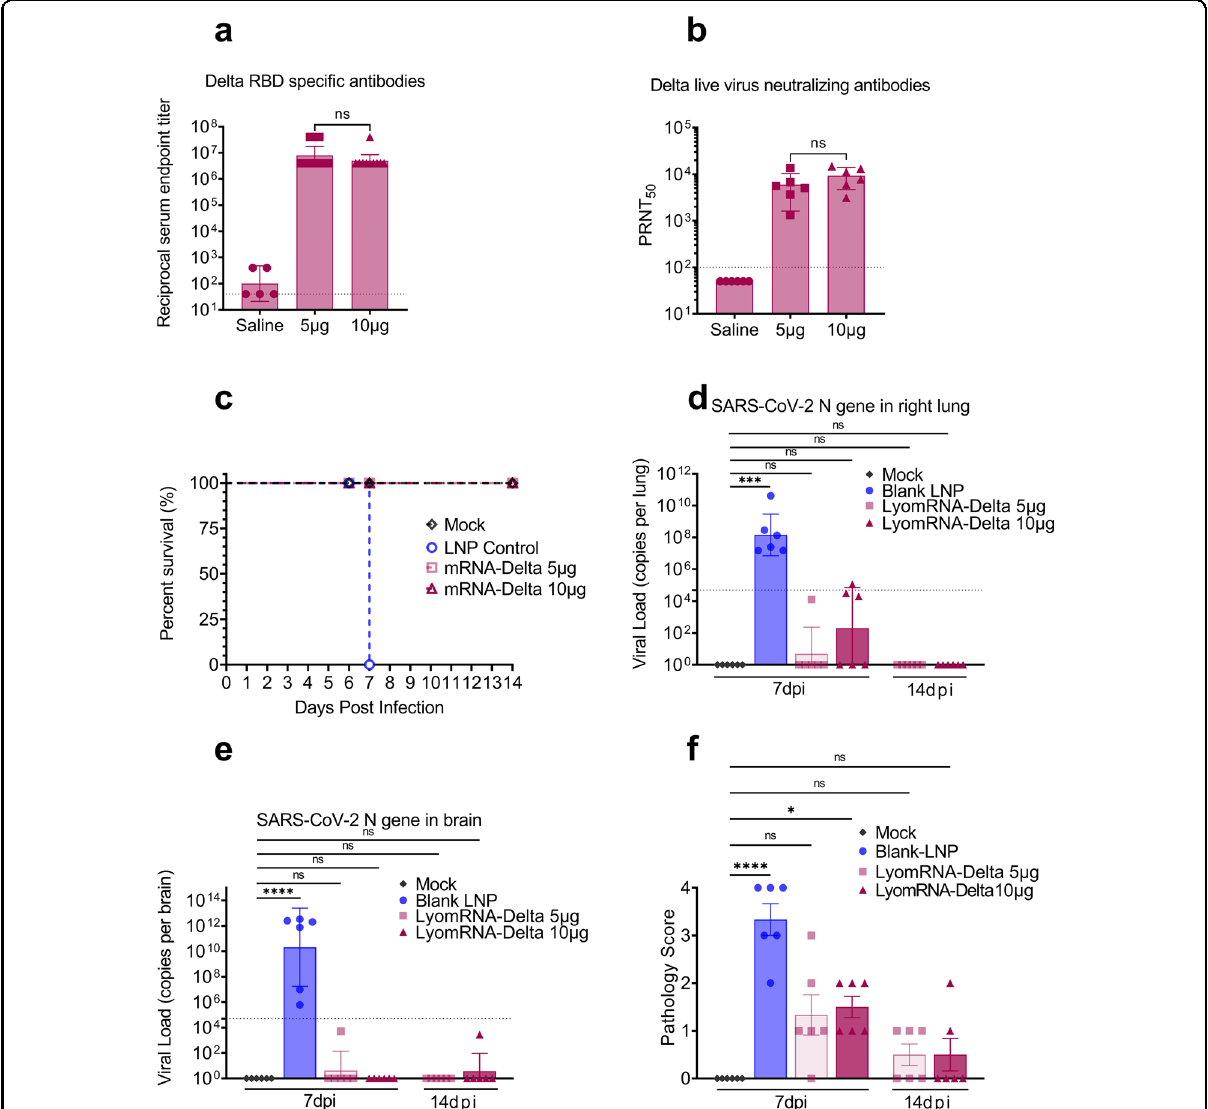
Fig. 2 LyomRNA-Delta elicits a potent immune response and protects mice from infection by Delta viruses. a BALB/c mice ( n = 10) were intramuscularly injected with saline or immunized twice at a dose of 5 μ g or 10 μ g at an interval of 14 days. Plasma samples were collected on D14 after the second dose to detect the Delta RBD-speci fi c binding antibody titers. b – f K18-hACE2 transgenic mice were injected with saline, blank LNP (LNP without mRNA), or intramuscularly inoculated with 5 μ g or 10 μ g of LyomRNA-Delta vaccine twice at an interval of 14 days, and two weeks after the second dose, 2.5 × 10 3 PFUs of SARS-CoV-2 Delta were administered to the animals intranasally. b Live SARS-CoV-2 Delta 50% neutralization titers 14 days after the second dose. c Animal survival curves after challenge. All blank LNP animals died or were euthanized 7 days after the challenge. d – f The virus load in the lungs ( d ), virus load in the brain ( e ), and pathology score ( f ) were evaluated 7 and 14 days after the challenge. Data are presented as the geometric means ± 95% con fi dence interval ( a , b ), geometric means ± geometric SD ( d , e ), or means ± SEM ( f ). a , b Doses were compared by a two-sided Mann – Whitney test. f Groups were compared to mock by Kruskal – Wallis ANOVA with Dunn ’ s multiple comparisons test. ns, not signi fi cant. * P < 0.05, *** P < 0.001. The horizontal dashed line marks the lower limit of detection (LLOD). Values below the LLOD were set to half the